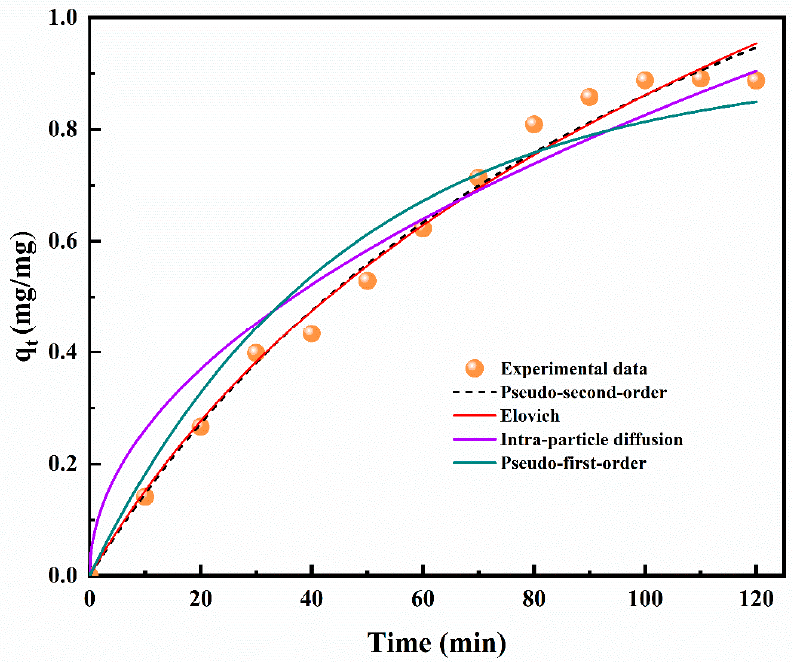
Figure 2. Thymol absorption in zinc layered hydroxide with non-linear fitted models.